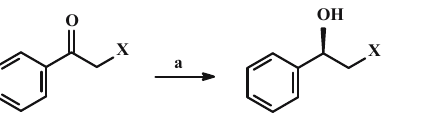
Figure 17: Scheme of stereogenic reduction of acetophenone derivatives X = Cl, Br. ( a ) BH 3 · S ( CH 3 ) 2 in THF or NaBH 4 or Rhodotorula rubra microbial culture; sodium lauryl